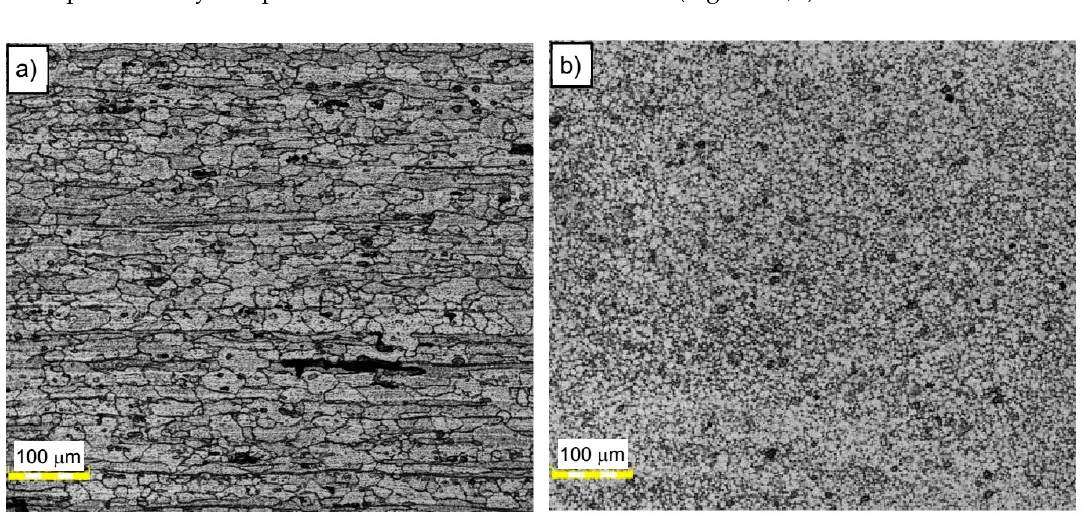
Figure 3. The cross-weld macrostructure of the 5083 FSW weld.